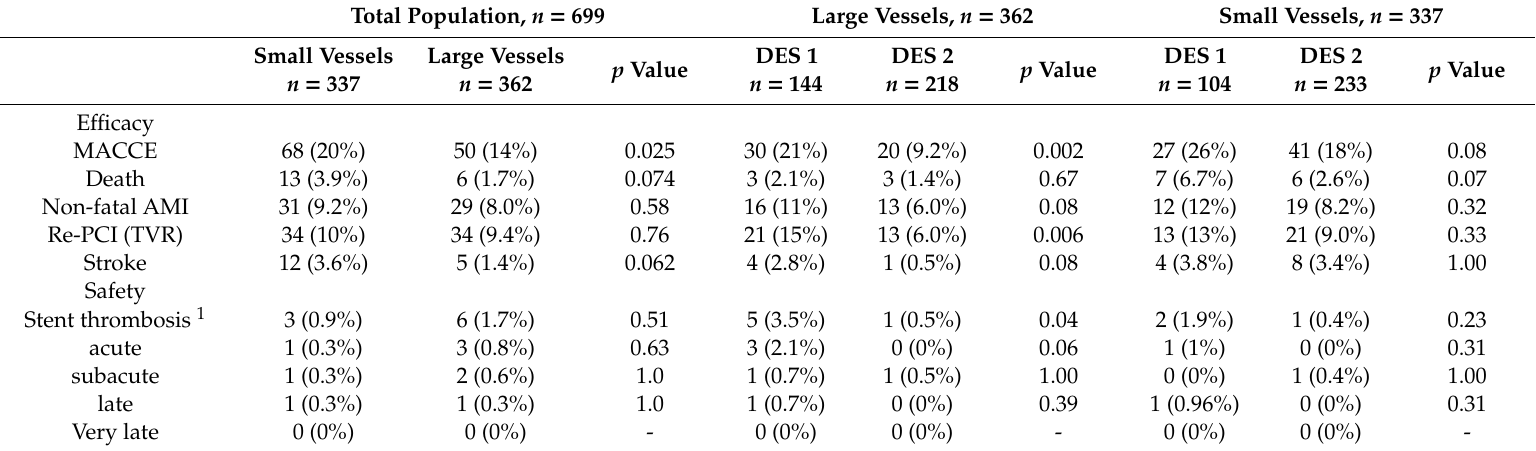
Table 3. Long-term